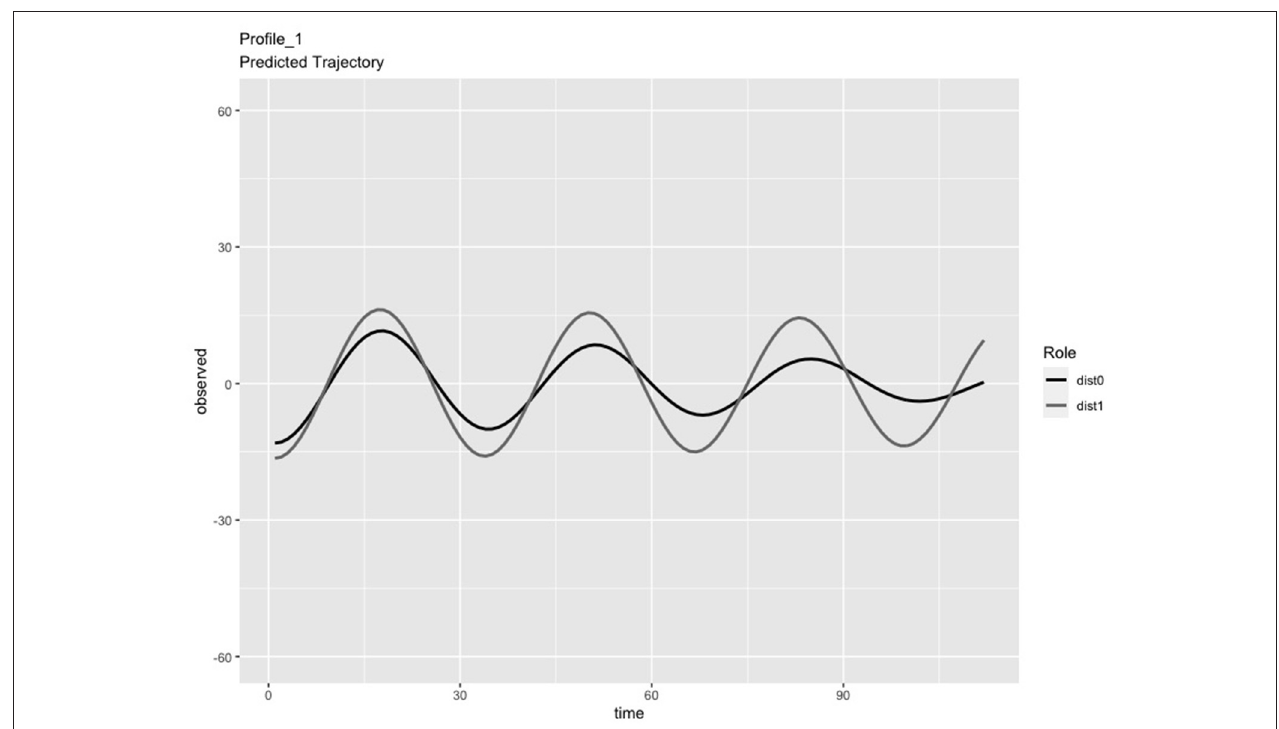
FIGURE 1 | Profile 1, labeled as Simple-Slow, was characterized by slow frequency, in-phase synchronization that showed one person’s signal damping over time ( n = 27 dyads).